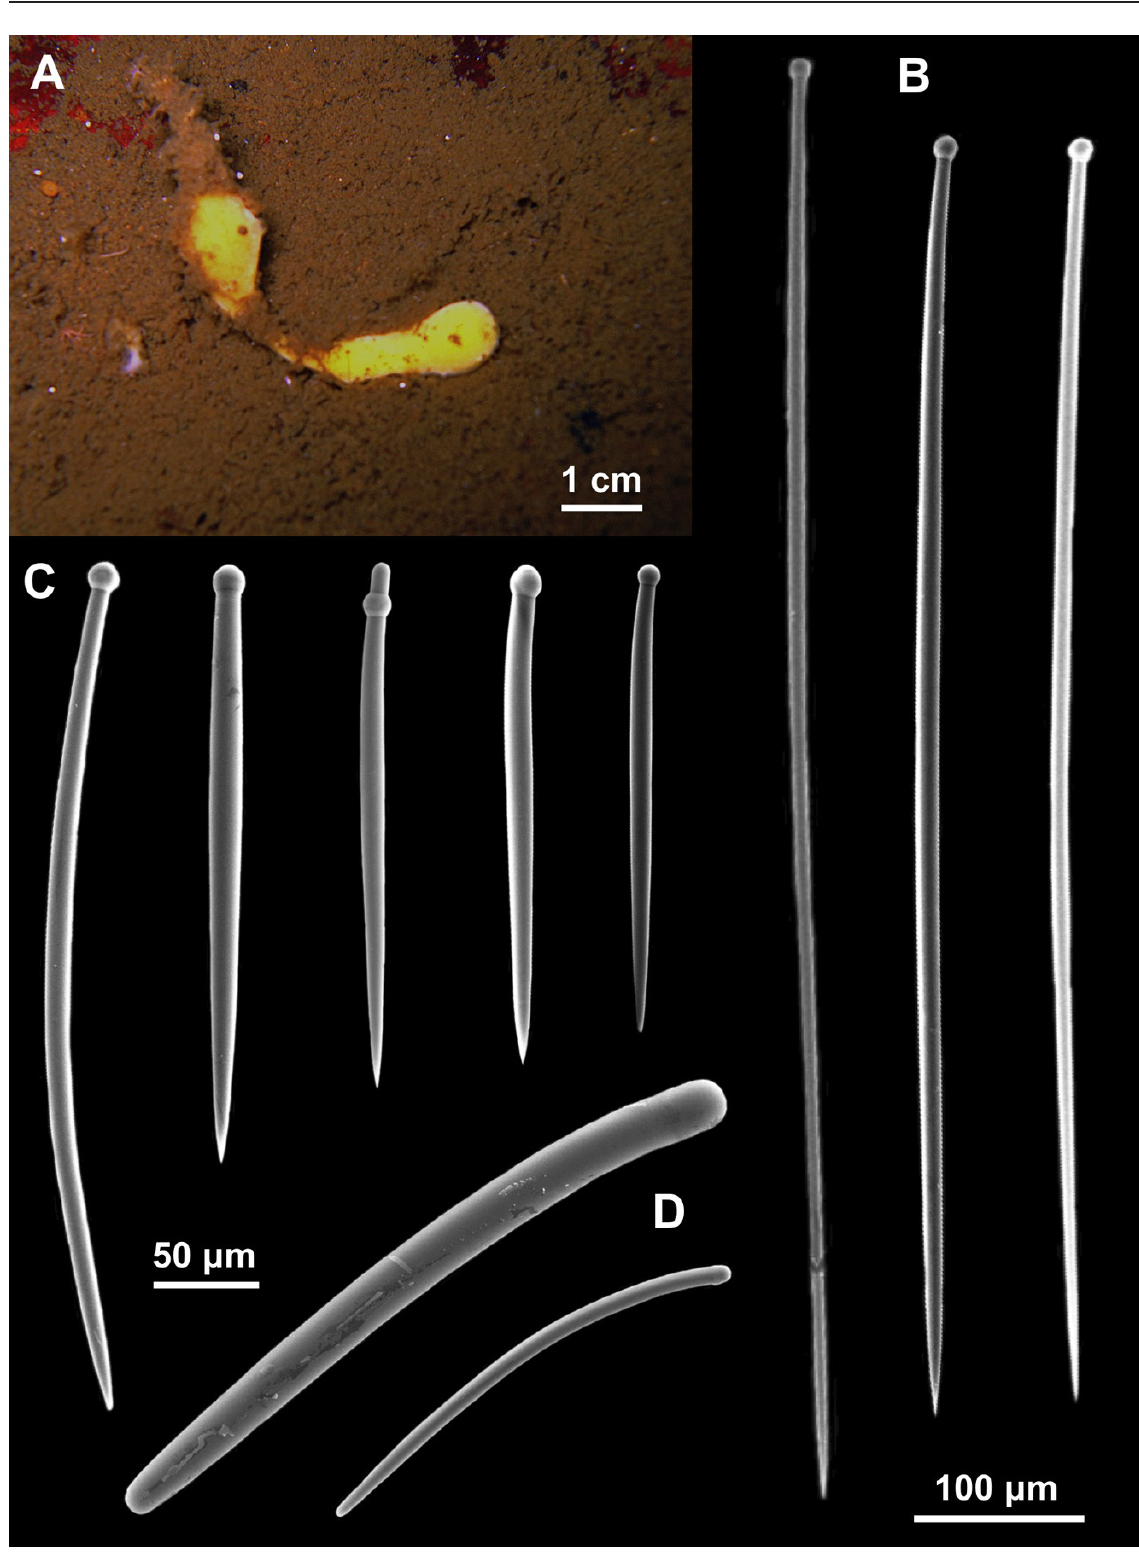
Fig. 14. Rhizaxinella strongylata Bertolino, Costa & Pansini sp. nov., holotype (CILE 65; MSGN 61499). A . The holotype in life. B . Tylostyles I. C . Tylostyles II. D . Strongyloid